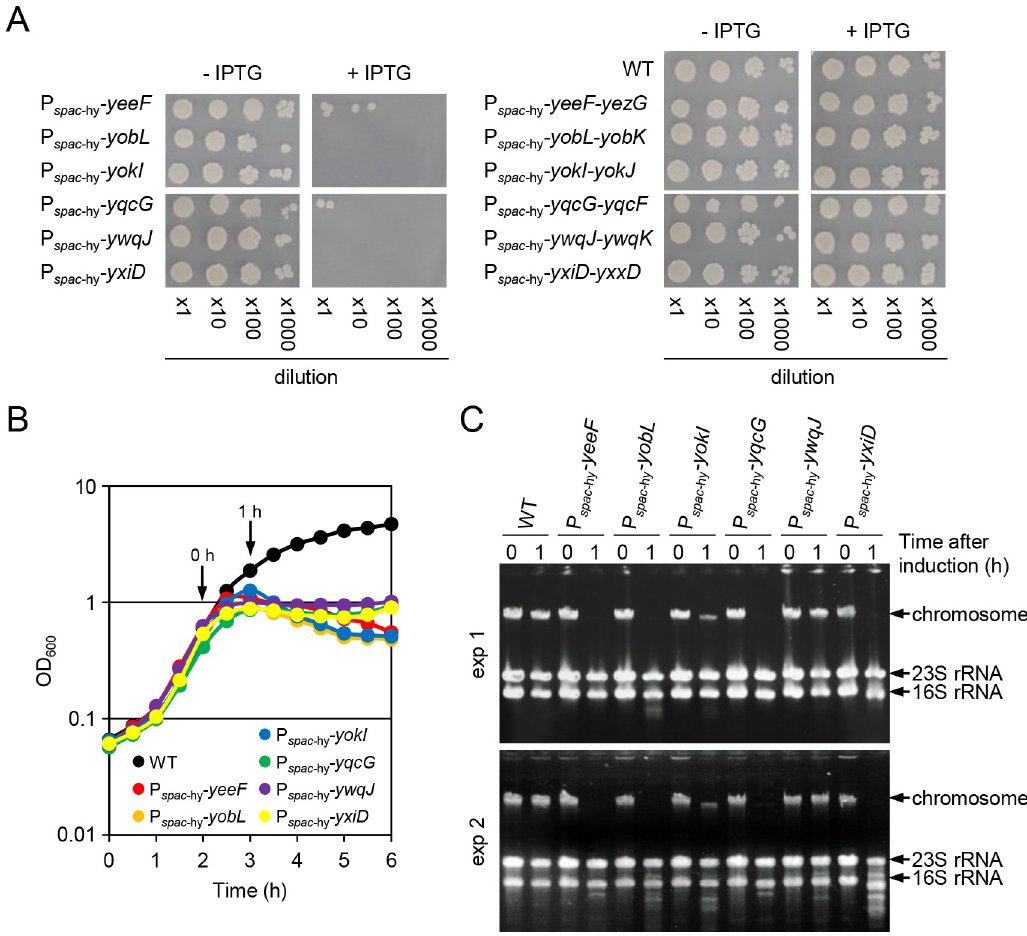
Fig 3. In vivo activity of LXG toxins and antitoxins. (A) Induction of LXG toxins prevents colony formation. Overnight cultures of P -LXG toxin gene strains (left panels) and P -LXG toxin-antitoxin operon strains (right panels) were spac -hy spac -hy serially diluted, and 2 μ l of the dilutions was spotted onto LB solid media with or without 1 mM IPTG. The wild-type strain was used as a reference. The plates were then incubated at 37˚C for 18 h. (B) Representative growth curves of wild-type (WT) and P -LXG toxin gene strains. Strains were grown at 37˚C in LB with vigorous shaking, and optical density at OD 600 was spac -hy monitored over time. IPTG (final concentration 1 mM) was added at the indicated time point (0 h). (C) The DNA and RNA content of cells before and after induction of LXG toxins. Cells were collected at 0 h and 1 h shown in panel B, samples of total DNA and RNA were isolated, and the samples from 0.03 OD cells were then analyzed by agarose gel electrophoresis. The positions of chromosome DNA and rRNAs are indicated by arrows. Results of two independent experiments are